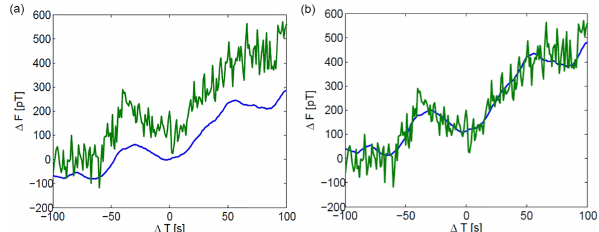
Figure 2. (a) Fluxgate data (green) and integral of induction coil signal (blue). (b) Blue curve fitted to FG data by adapting C , (cid:49)U and B X (t 0 ) in Eq. (2). In this plot, fluxgate data (cid:49)F are referred to an arbitrary base value to get handy numerical values on the axis of